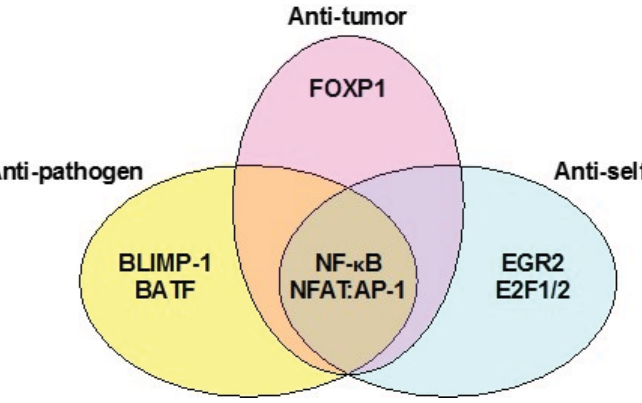
Figure 1. Overlap of key transcriptional networks underlying hypofunction of anti-tumor, exhaustion of anti-pathogen, and tolerance or anergy of anti-self CD8+ T